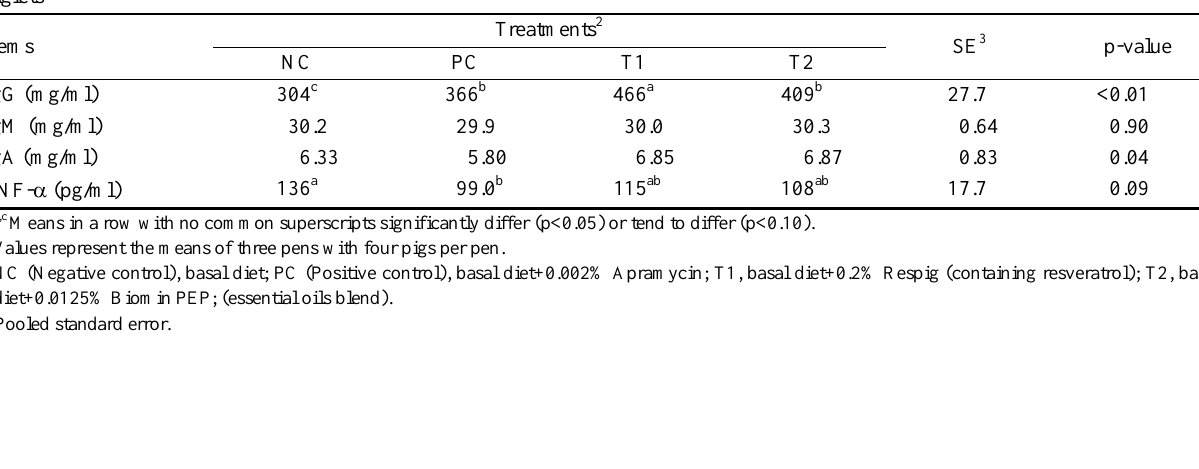
Table 3. Effects of resveratrol and essential oils blend on serum levels of immunoglobulins (mg/mL) and TNF-  (pg/mL) of challenged piglets